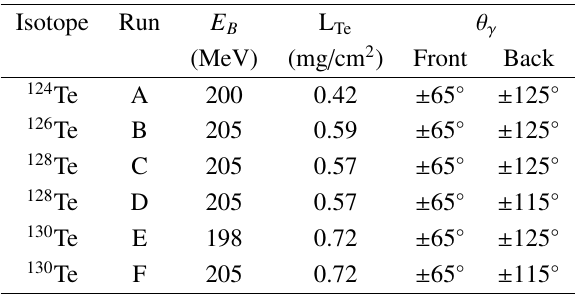
Table 1. Experimental details: E B is the 58 Ni beam energy and L Te is the target thickness. The angles θ γ are the polar angles to the centres of the Clover